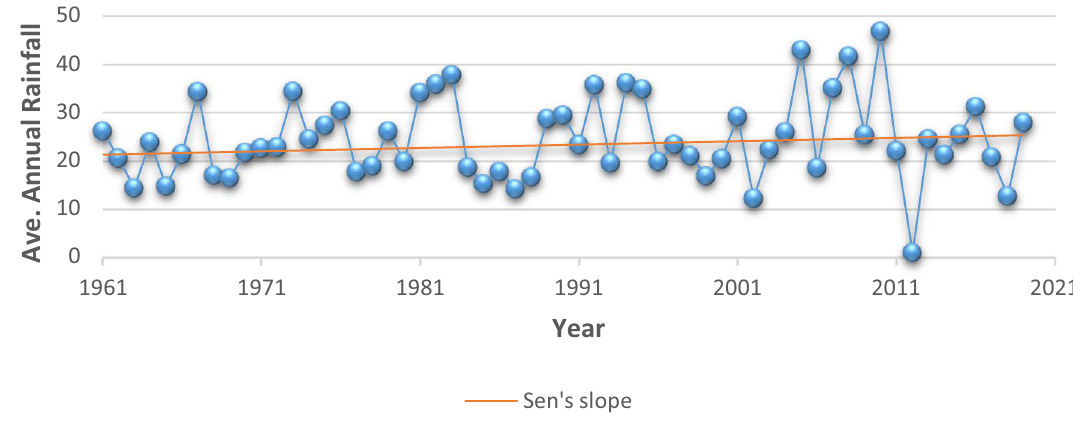
Fig. 4 A plot of average annual rainfall for Dera Ismail Khan station. Data Source : Pakistan Meteorological Department and Regional Mete- orological